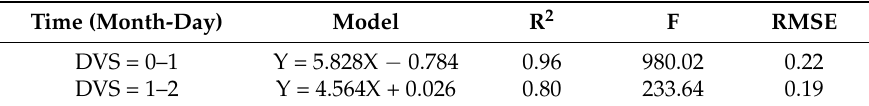
Table 8. The regression models for LAI calculation.